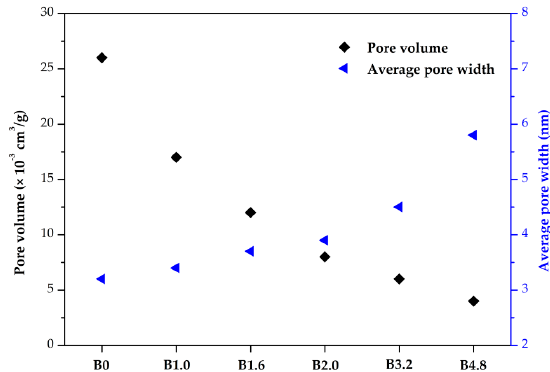
Figure 3. Pore volumes and average pore widths of biochar obtained from the pyrolysis of rice husks with different boric acid contents. (B0, B1.0, B1.6, B2.0, B3.2, and B4.8 were biochar samples prepared by the pyrolysis of rice husks with boric acid contents of 0, 1.0 wt %, 1.6 wt %, 2.0 wt %, 3.2 wt %, and 4.8 wt %, respectively.)